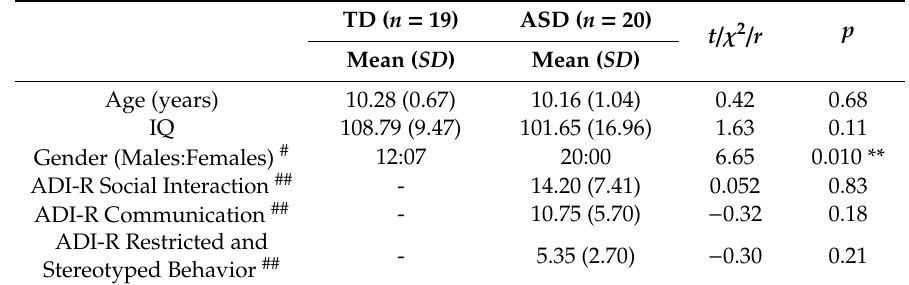
Table 1. Demographic, intellectual, and clinical characteristics of the typically developing (TD) and autism spectrum disorder (ASD)